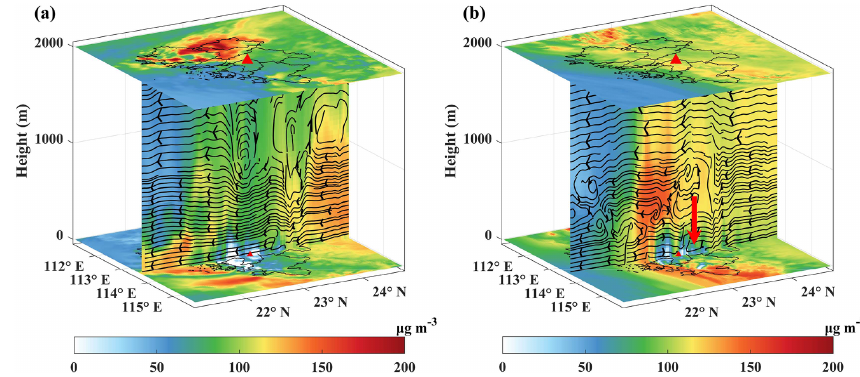
Figure 11. Vertical profiles of O 3 concentrations at 21:00LT during (a) a normal day (12 September 2017) and (b) an NOI event (13 September 2017). Red triangles represent the NCYL site in Dongguan, contours represent O 3 concentrations (µgm − 3 ), and black lines and arrows indicate vertical airflow and its direction.